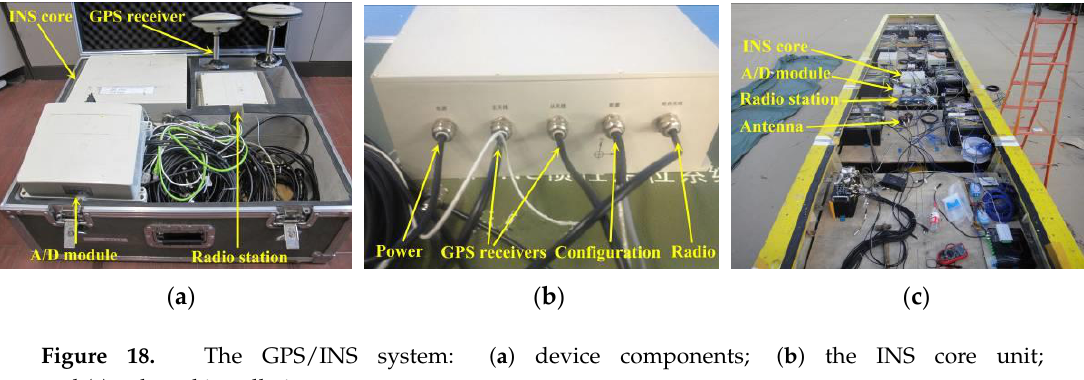
Figure 18. The GPS/INS system: ( a ) device components; ( b ) the INS core unit; and ( c ) onboard installation.